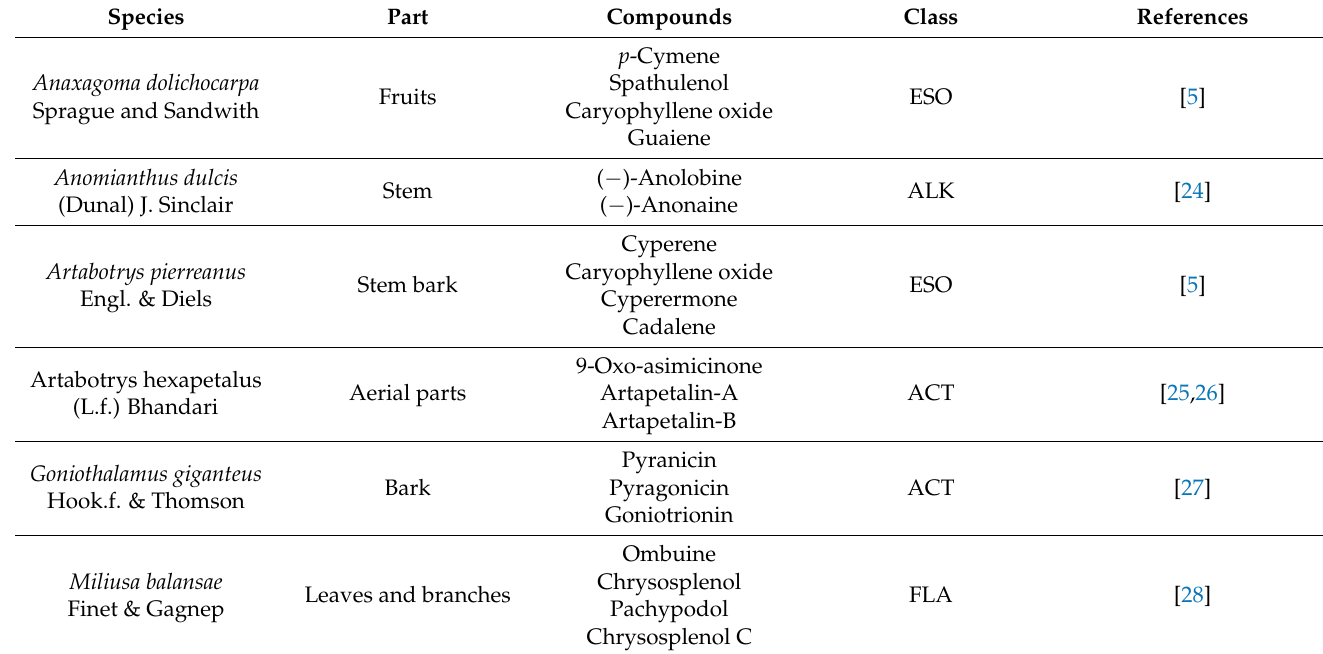
Table 2. Representative phytochemicals isolated from plants of